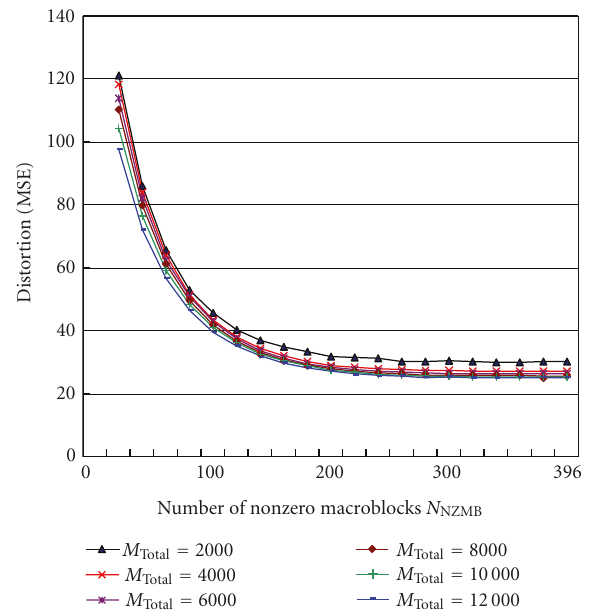
Figure 6: The distortions of the Weather sequence for di ff erent numbers of nonzero macroblocks ( N NZMB ) and SAD operations ( M Total